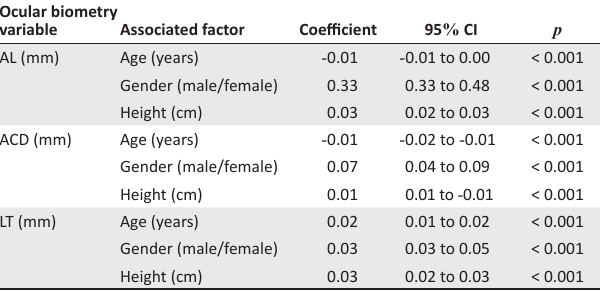
The blue diamond shapes represents the scatter plot for axial length and age; the dotted black line indicates the linear regression line of axial length with age. The regression line indicates axial length = 23.97 – 0.01Age. The orange squares show the scatter plot for anterior chamber depth and age with the corresponding linear regression line indicated by the solid black line. The regression line is: anterior chamber depth = 3.74 – 0.01 Age. The grey triangular shapes are for the scatter plot of lens thickness and age; the dashed black line is the linear regression of lens thickness with age. The regression line indicates lens thickness = 2.38 + 0.02Age. AL, axial length; ACD, anterior chamber depth; LT, lens thickness. FIGURE 1: Scatter plots and linear regression analysis showing the correlation between age ( x -axis) and biometric parameters (axial length, anterior chamber depth and lens thickness) in the y -axis measured with the Nidek US-500